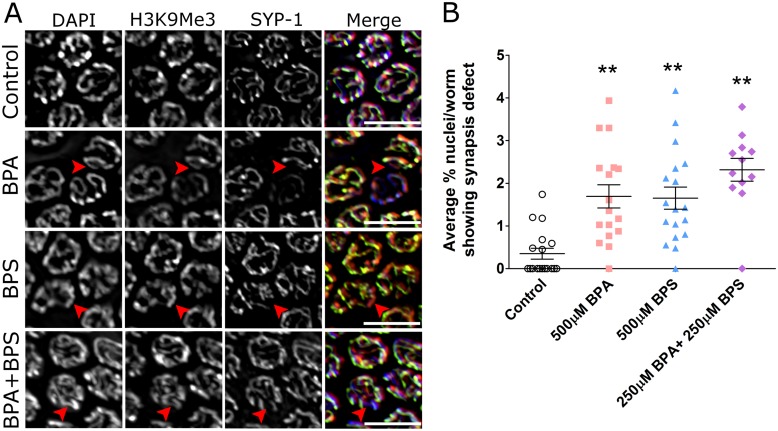
Bisphenol S exposure impairs homologous chromosome synapsis.(A) Partial chromosome synapsis is observed in mid-to-late pachytene nuclei of worms exposed to 500 μM BPA, 500 μM BPS or to their mixture as revealed by SYP-1 (green) and H3K9me3 (red) immunostaining and DAPI (blue). Red arrowheads indicate the chromosomal area lacking SYP-1 expression but displaying H3K9me3 staining. In the BPA exposed germline, one nucleus shows very reduced SYP-1 levels and is likely apoptotic (Scale bar, 10 μm). (B) Average percentage of pachytene nuclei with partial SYP-1 staining for each treatment group. Error bars represent SEM. N = 4–6 worms per trial, three repeats per treatment group. T-test based analysis. **P<0.01.